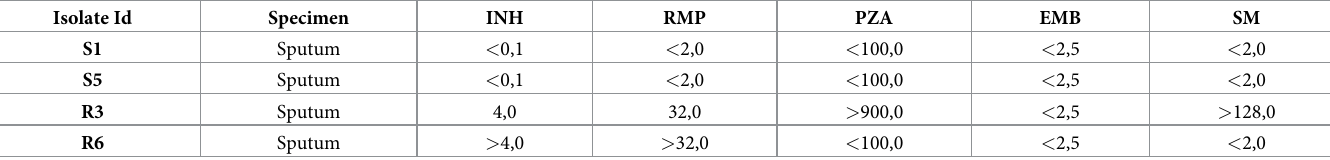
Table 1. Minimal inhibitory concentration (MIC) of Mycobacterium tuberculosis clinical isolates used in the present study. Isolate